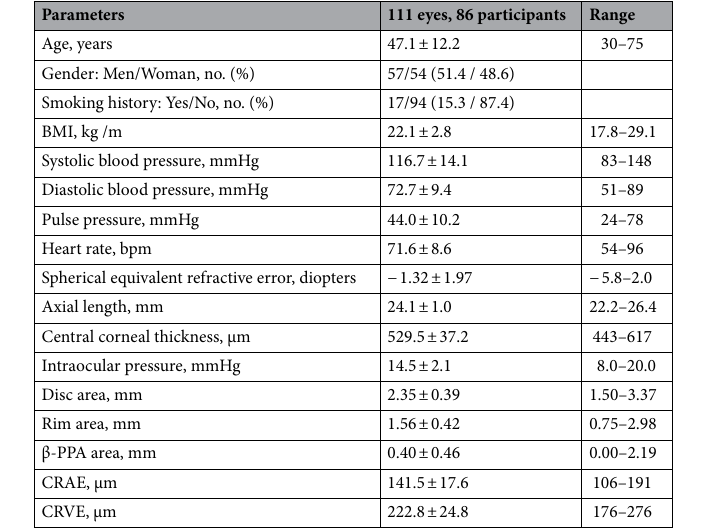
Table 1. Characteristics of participants. The values are represented as mean ± standard deviation. AU arbitrary unit, CRAE central retinal artery equivalent, CRVE central retinal vein equivalent, MBR mean blur rate, MT MBR in the optic nerve head tissue area, MV MBR in the optic nerve head vessel area, PPA peripapillary